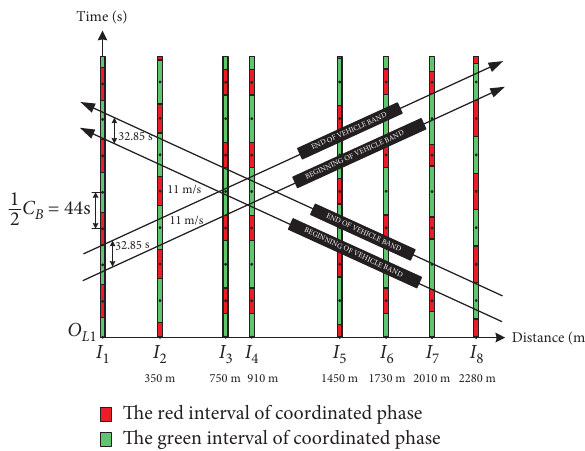
Figure 14: The finally obtained time-space